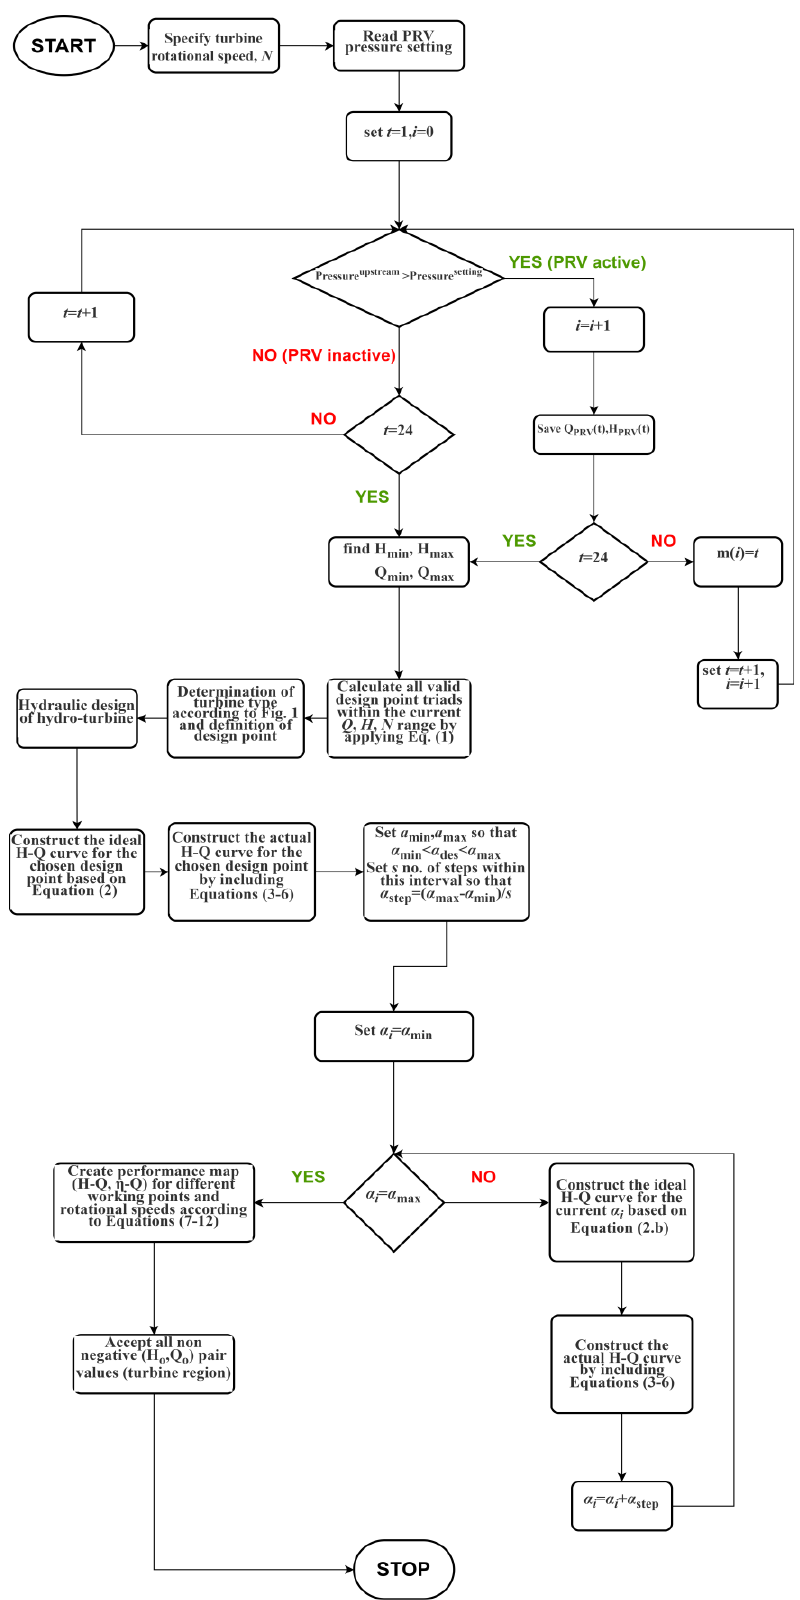
Figure 4. Turbine design and performance prediction process.